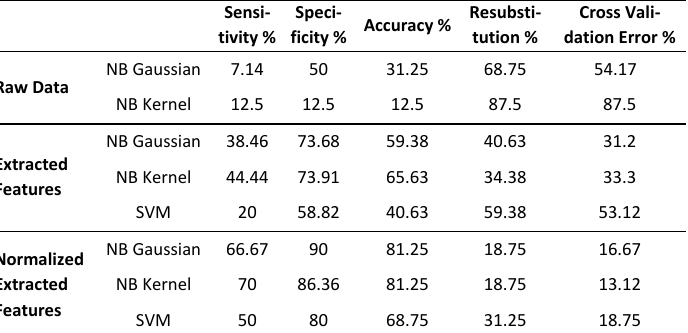
Figure 9: Comparison of the performance of 3 classification methods on the data. Table 2: The performance of various classification methods on raw and processed